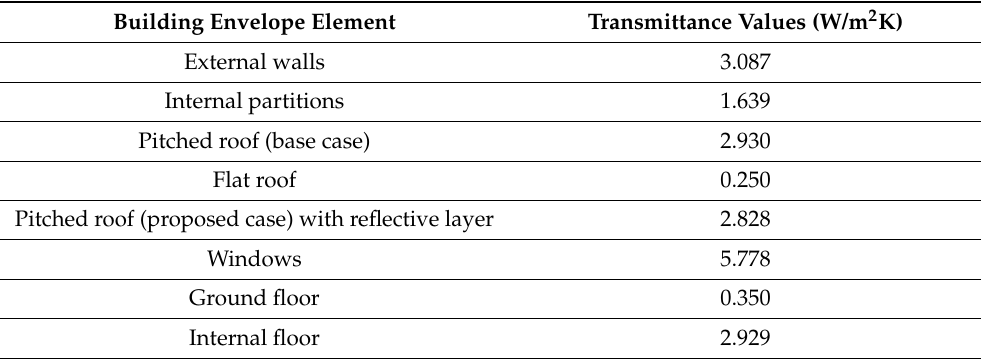
Table 2. Characteristics of materials employed in the 3D model. Own elaboration.